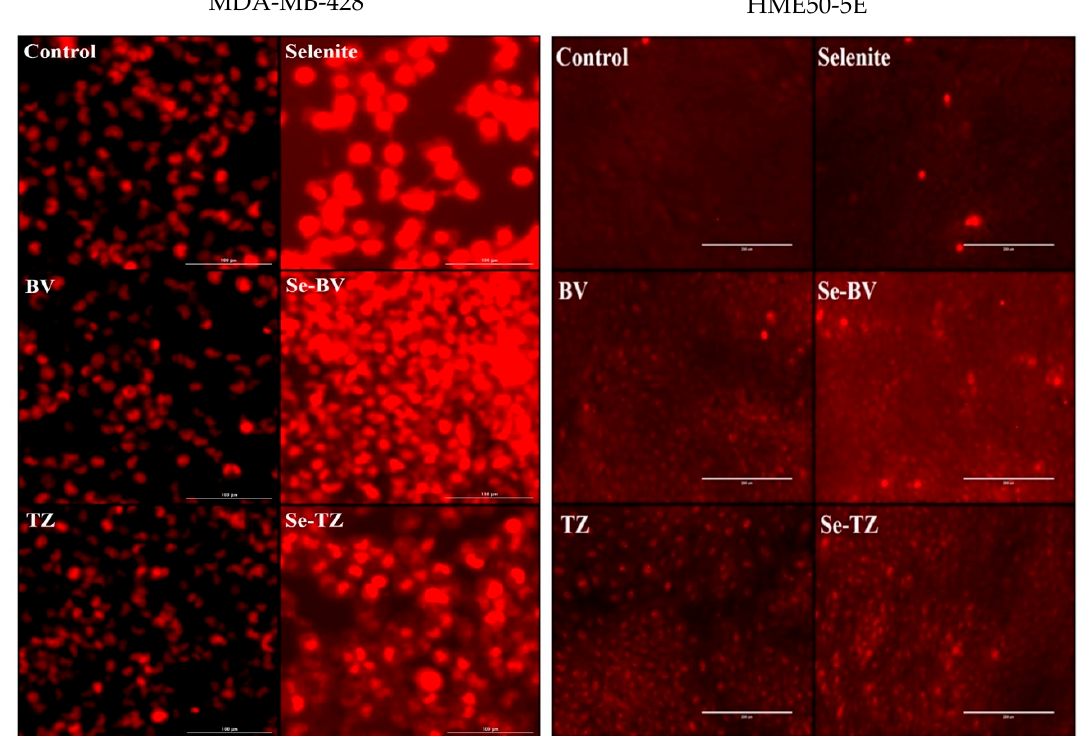
Figure 6. Photomicrographs of intracellular superoxide generation by DHE red florescence from MDA-MB-468 Cells (Left Panels) and HME50-5E cells (Right Panels). Results were photographed after 30 min of treatment with Control, selenite (10 µg Se), BV (153.7 µg protein), Se-BV (10 µg Se and 153.7 µg protein), TZ (131.1 µg protein), and Se-TZ (10 µg Se and 131.1 µg protein).